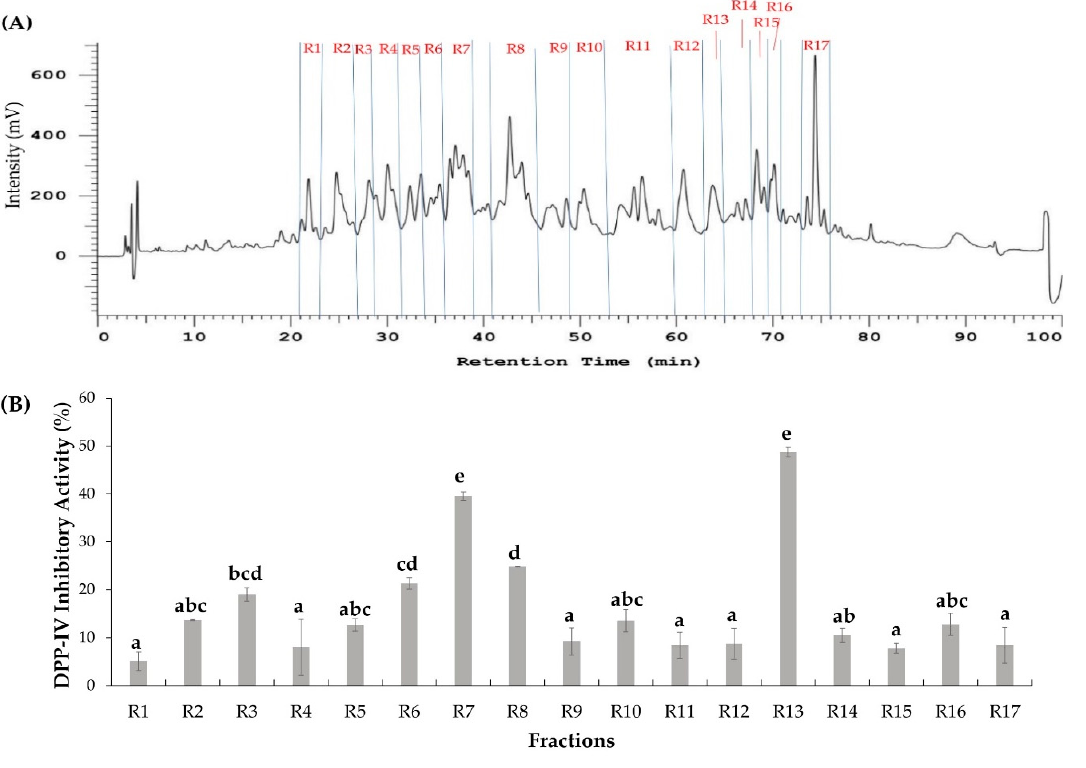
Figure 2. ( A ) Reverse-phase HPLC chromatogram with 10 mm × 250 mm, 5 µm column of turtle yolk hydrolysate. ( B ) DPP IV—Inhibition activity of RP-HPLC fractions (R1–R17). ( C ) DPP-IV inhibition activity of SCX fractions (S1–S10). Different letters (a–g) indicate significant differences between samples ( p < 0.05). 2.3. Database-Assisted Peptide Sequencing and In Silico Prediction of Potential DPP-IV Inhibitory Peptides The peptide sequences in fractions R7 and R13 of RP separation and fraction S2 of SCX separation were identified by LC-MS/MS analysis coupled with a database-assisted sequencing using the protein database of P. sinensis downloaded from NCBI. Twenty-one peptides were identified from fraction SCX-S2; while seven and nine peptides were identified from the RP-R7 and RP-R13 fractions, respectively. The information of identified peptides from SCX-S2, RP-R7, and RP-R13 fractions was summarized on Table 1. Two peptides including VPGLAL and LPSW were identically identified from SCX-S2 and RP-R7; while three identical peptides (LPLF, LVGLPL, and WLQL) were also characterized from SCX-S2 and RP-R13 (Table 1). The distribution of these five overlapping peptides in LC-MS chromatogram of SCX-S2 fraction was indicated on Figure 3A.